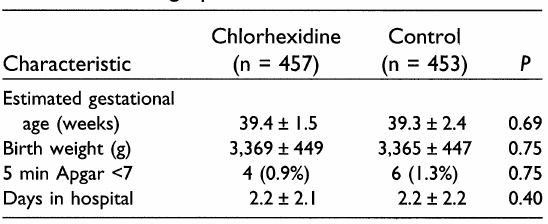
TABLE I. Demographic